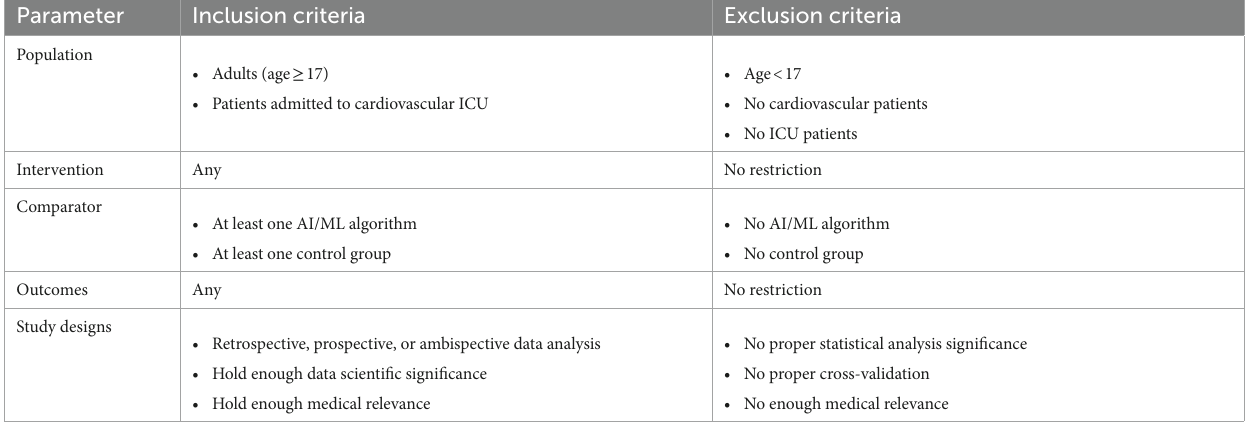
TABLE 1 Population, intervention, comparator, outcome, and study design (PICOS) criteria for the systematic review.